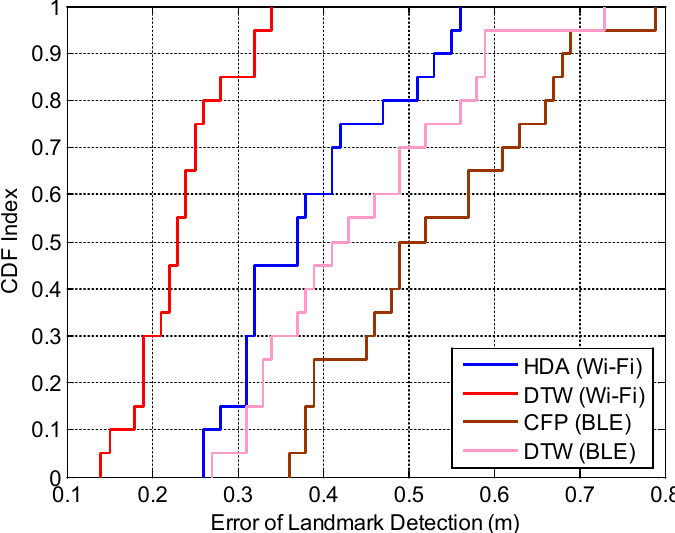
Figure 11. The Errors Comparison of Landmark Detection Algorithms.